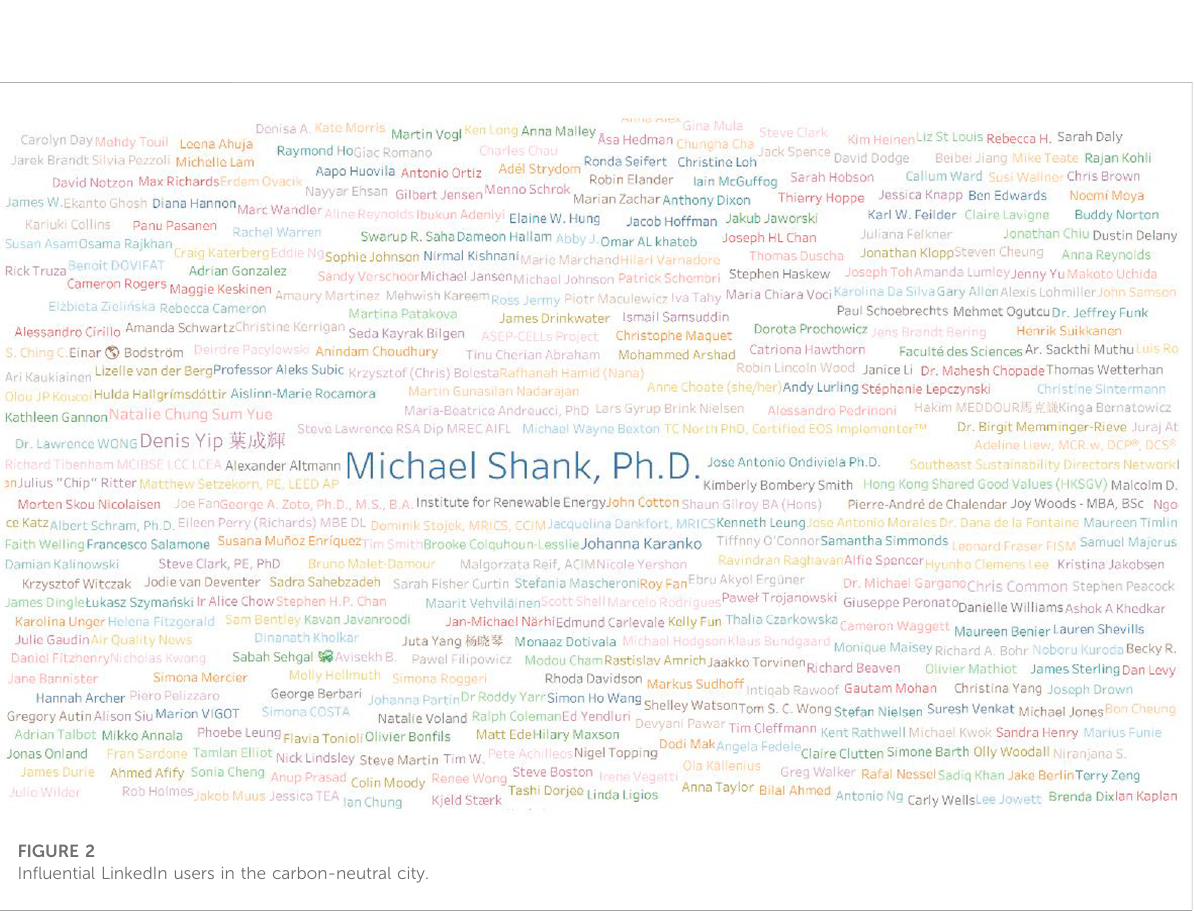
Word frequency in the carbon-neutral city from LinkedIn.